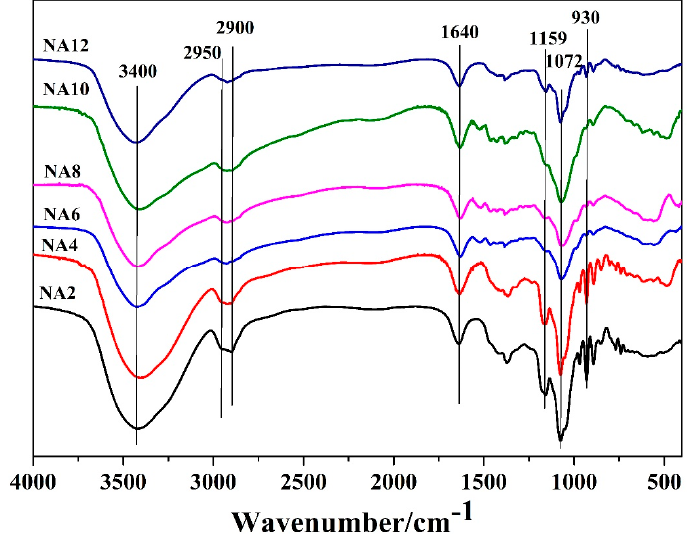
Figure 6. FTIR spectrum of NAOS.